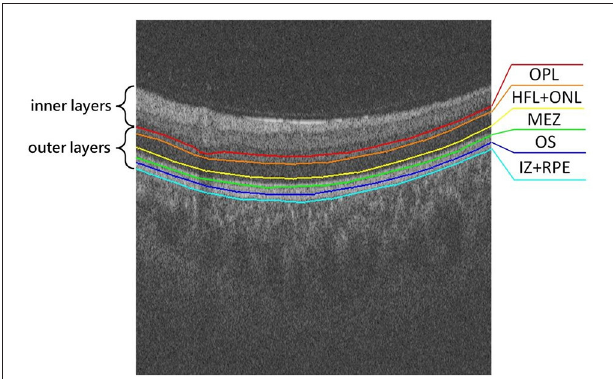
FIGURE 1 | Illustration of the outer retina layered structure, from top to bottom: outer plexiform layer (OPL), Henle fiber layer and outer nuclear layer (HFL+ONL), myoid and ellipsoid zone (MEZ), photoreceptor outer segments (OS), interdigitation zone and retinal pigment epithelium/Bruch complex (IZ+RPE).